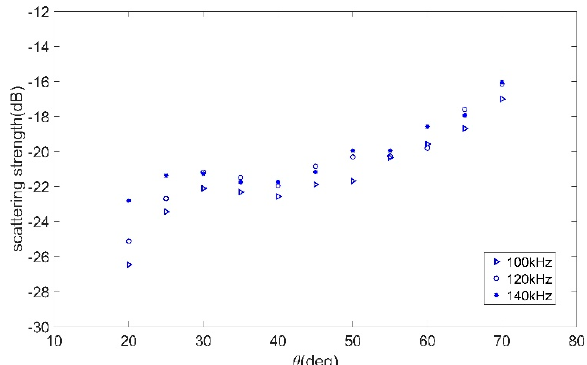
Figure 3. Measured backscattering strength as a function of grazing angle of different frequencies.